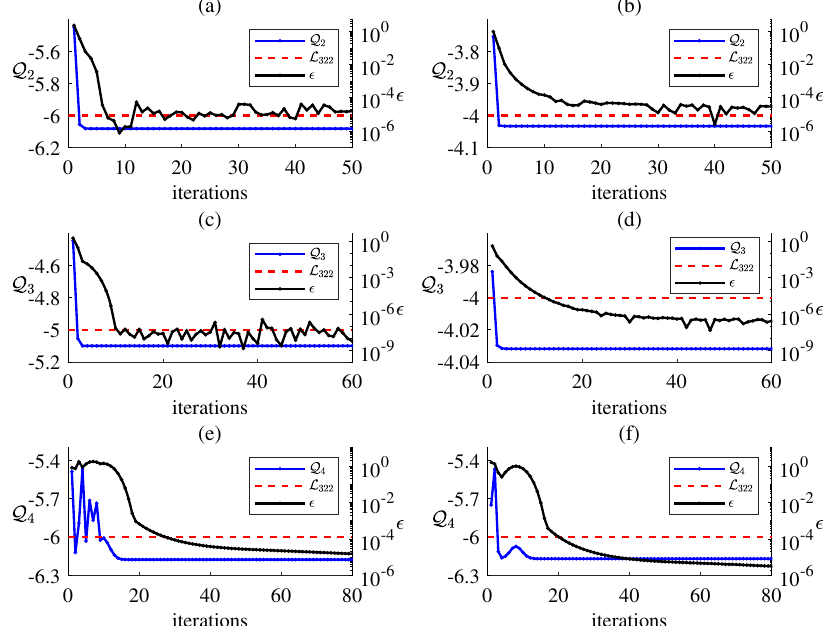
Fig. 2 Convergence of our algorithm for selected Hamiltonians. The ground state energy density Q d (blue line) and two-norm of gradient ϵ (black line) for selected 322-type TI quantum systems with the local observable dimension d = 2, 3, 4. The red dashed line represents the classical bound, and the regions below show contextuality. a Q 2 of No. 1 in Supplementary Table 2. b Q 2 of No. 38 in Supplementary Table 2. c Q 3 of No. 7 in Supplementary Table 2. d Q 3 of No. 30 in Supplementary Table 2. e Q 4 of No. 37 in Supplementary Table 2. f Q 4 of No. 54 in Supplementary Table 2.